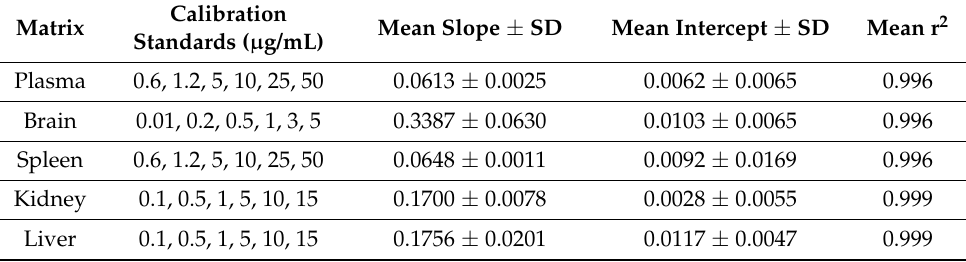
Table 3. Mean calibration curve parameters obtained from weighted linear regression analysis (1/x 2 ) for celecoxib in studied mouse matrices (n = 6, mean ± SD). Key—SD, Standard deviation; r 2 , determination